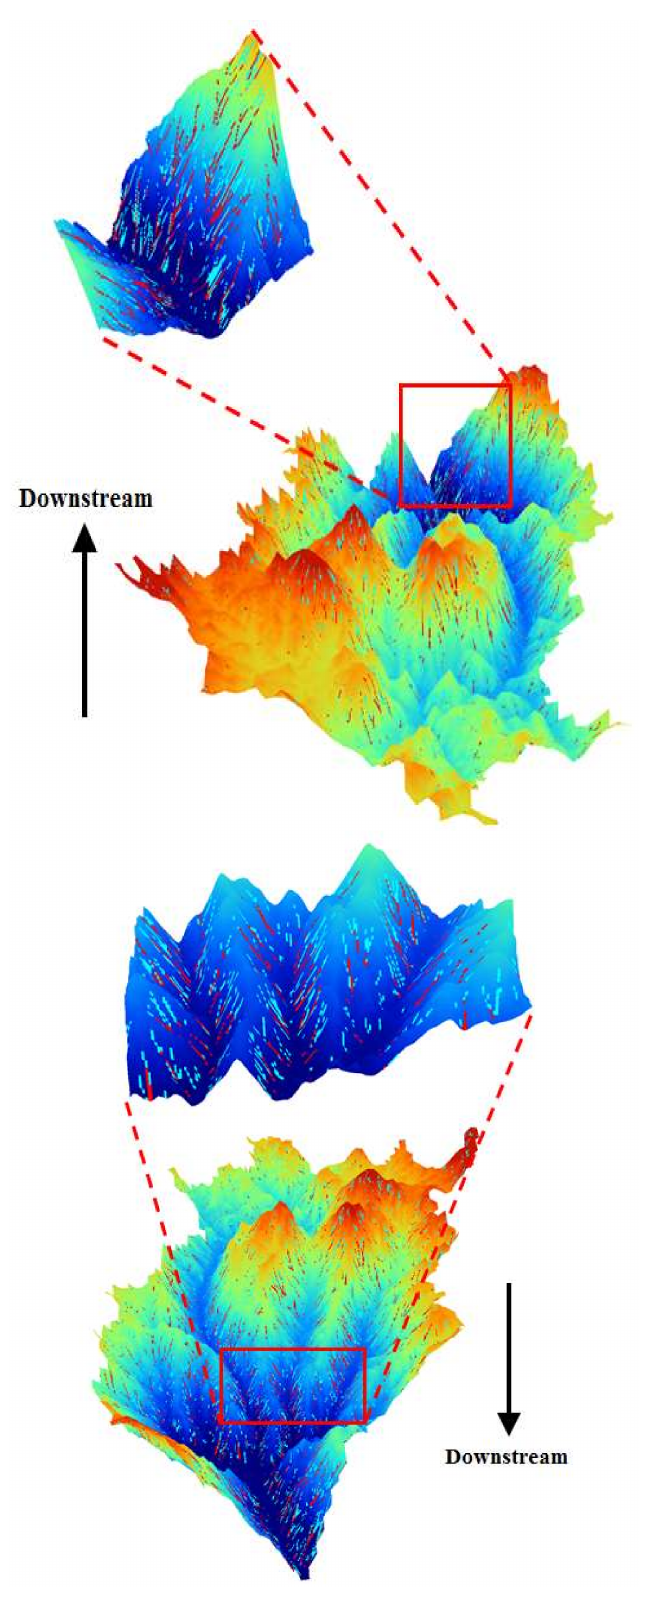
Figure 9. Three-dimensional views of a region vulnerable to soil